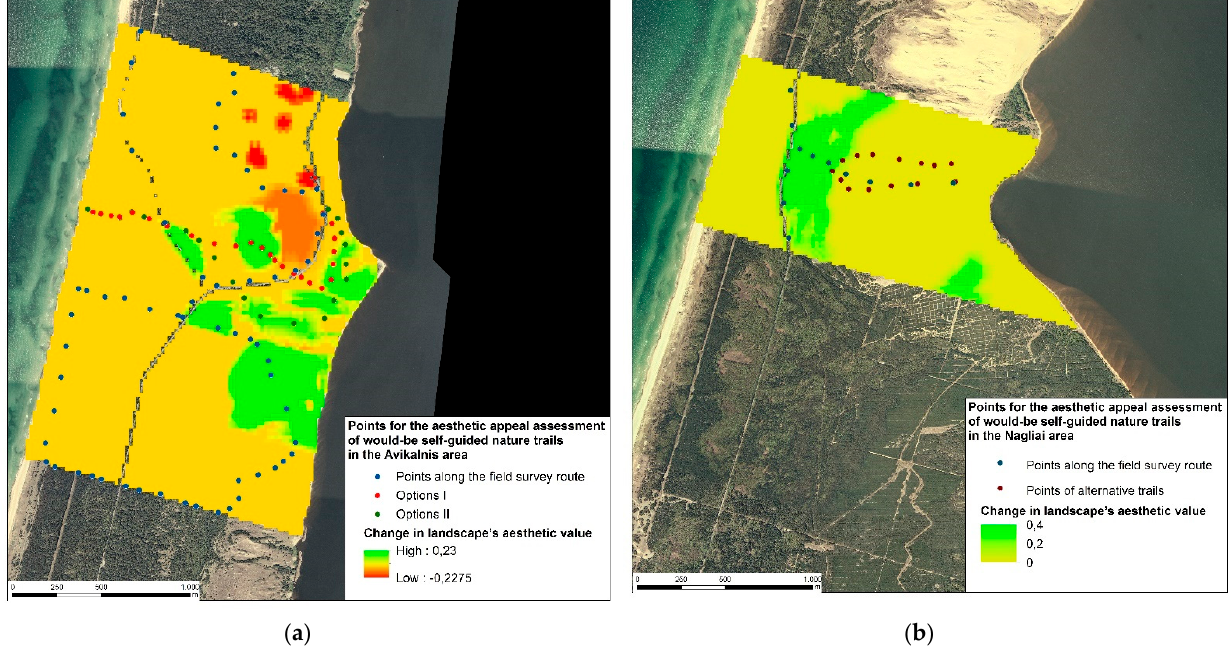
Figure 13. ArcGIS layer of the zones with scenic quality changes resulting from intervention measures or natural succession from 2010 to 2020: ( a ) Northern part of Nagliai Strict Reserve and its buffer zone; ( b ) Southern part of Nagliai Strict Reserve and its buffer zone. Yellow—no scenic value change; red—negative changes; green—positive changes field survey points marked as black dots. Note the decline of scenic quality in the buffer zone of the northern part of Nagliai Strict Reserve due to the overgrowth of grey dunes resulting from the natural succession. (Drawn by Arvydas